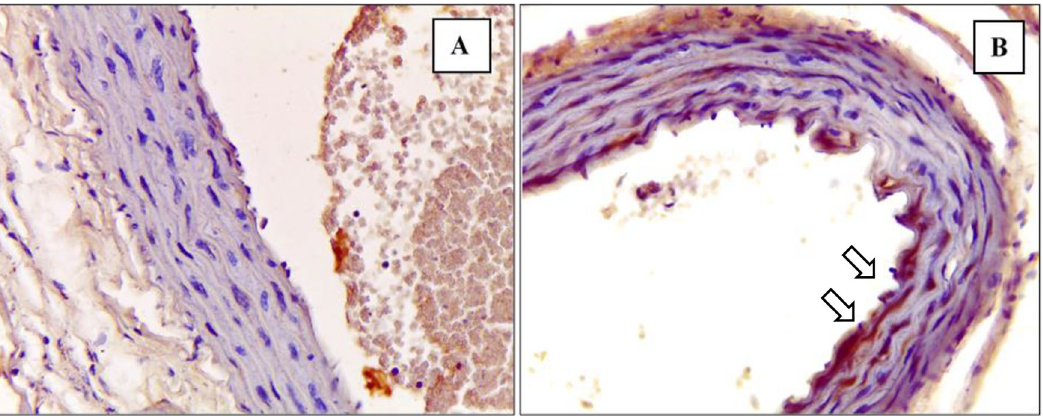
Figure 3. Immunohistochemical staining of M1 expression by CD38 (white arrow) on (A) Negative control (B) Positive